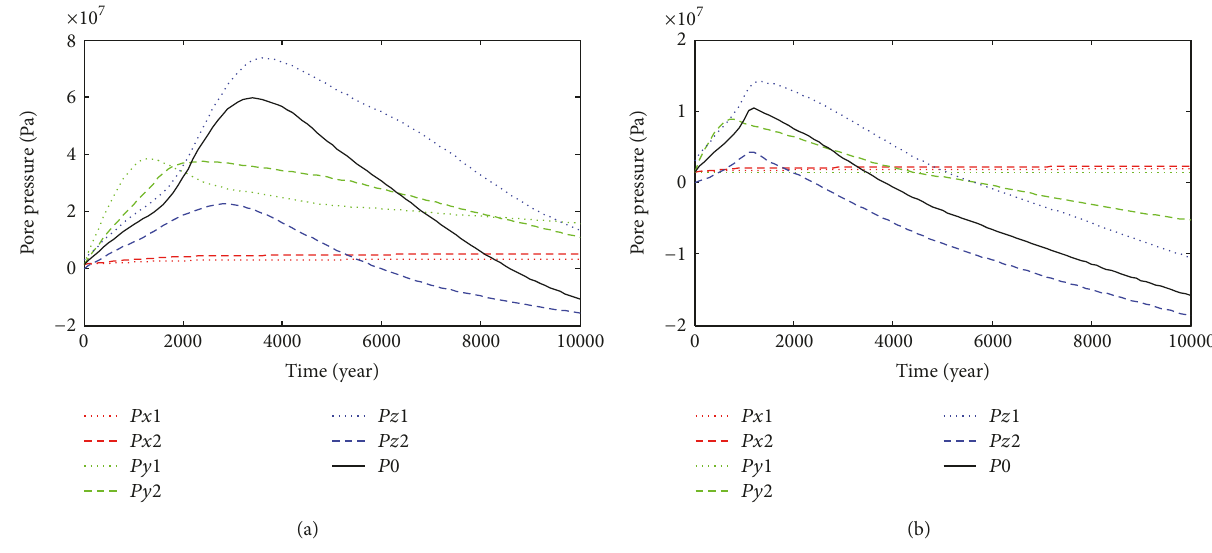
Figure 9: Changes of the pore pressure ( 𝑃 ) with time at the seven observation points for (a) Model I and (b) Model